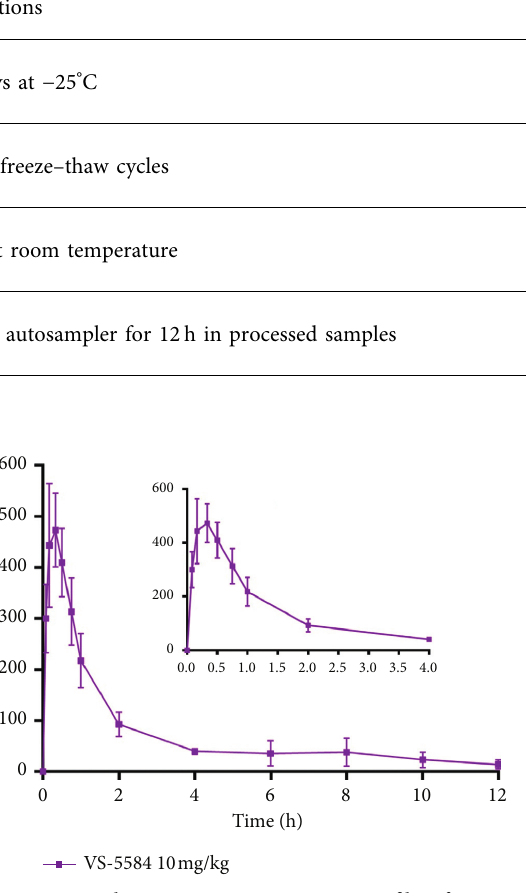
Figure 3: Mean plasma concentration-time profile of VS-5584 ( n � 6).